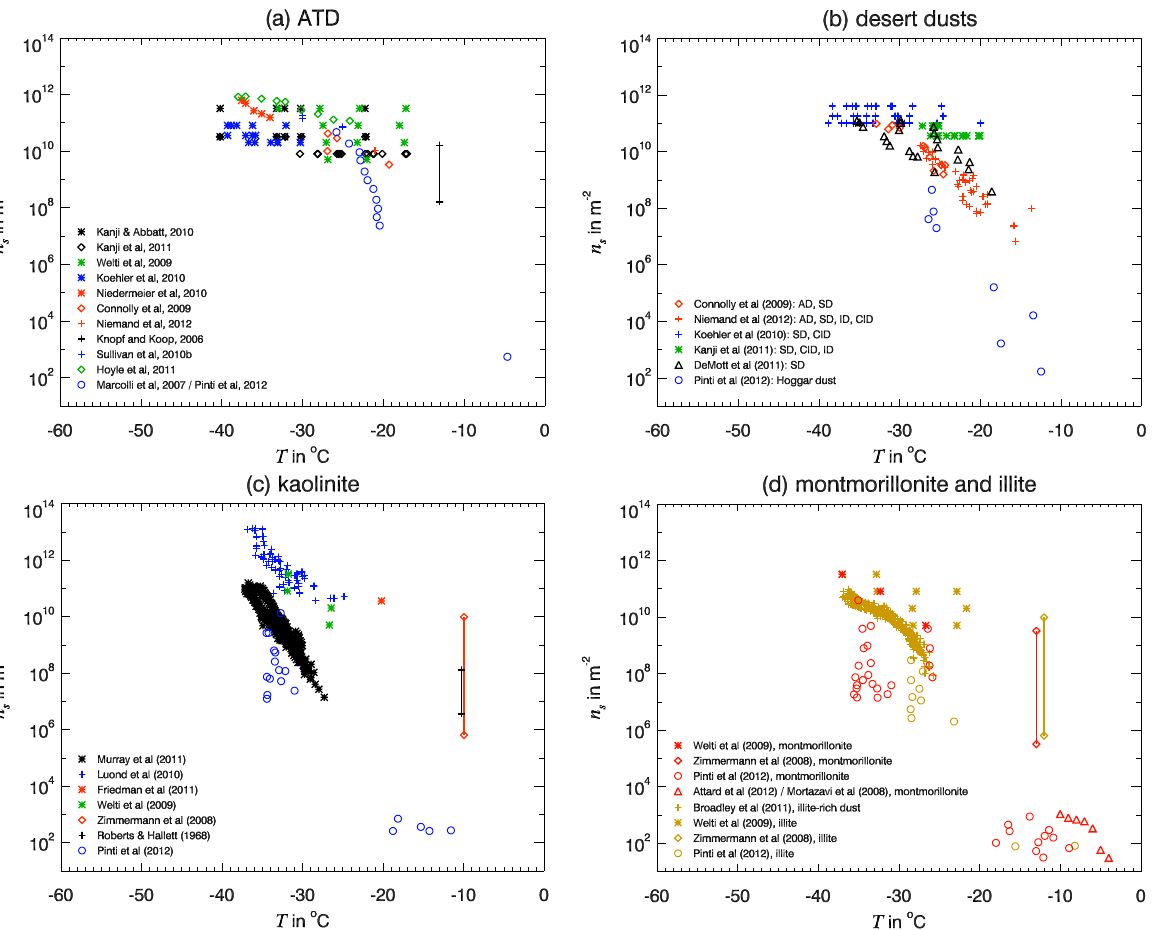
Fig. 11. INAS densities for ATD, natural desert dusts and different clay minerals for immersion freezing, including deposition/condensation freezing experiments at or above water saturation. The INAS densities are derived either by assuming spherical particles or with BET surface areas (Murray et al., 2011; Broadley et al., 2012; Pinti et al., 2012; Attard et al., 2012). The data by Connolly et al. (2009) have been corrected by a factor of 10 as described in Niemand et al.